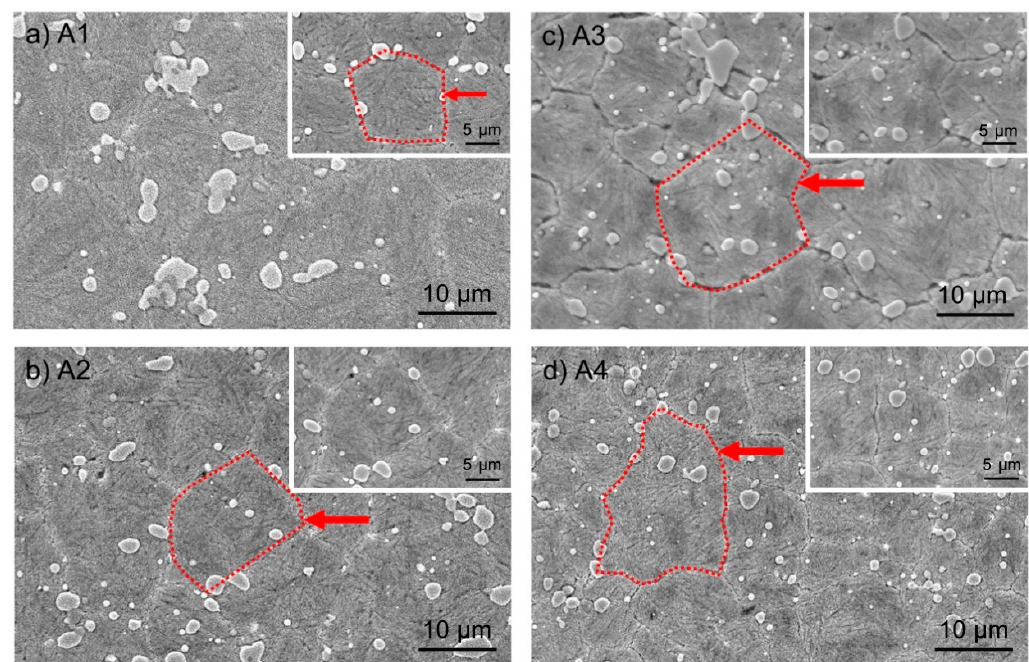
Figure 3. Microstructures of grade A steel after conventional heat treatments: ( a ) A1: 2 min of austenitization at temperature T A = 1230 ◦ C and 3 × 1 h tempering at temperature T T = 550 ◦ C; ( c ) A3: 2 min of austenitization at temperature T A = 1180 ◦ C and 3 × 1 h tempering at temperature T T = 620 ◦ C; and heat treatment procedures with deep cryogenic treatment: ( b ) A2: 2 min of austenitization at temperature T A = 1230 ◦ C, 24 h of DCT at temperature T DCT = − 196 ◦ C and 1 h tempering at temperature T T = 550 ◦ C; ( d ) A4: 2 min of austenitization at temperature T A = 1180 ◦ C, 24 h of DCT at temperature T DCT = − 196 ◦ C and 1 h tempering at temperature T T = 620 ◦ C.